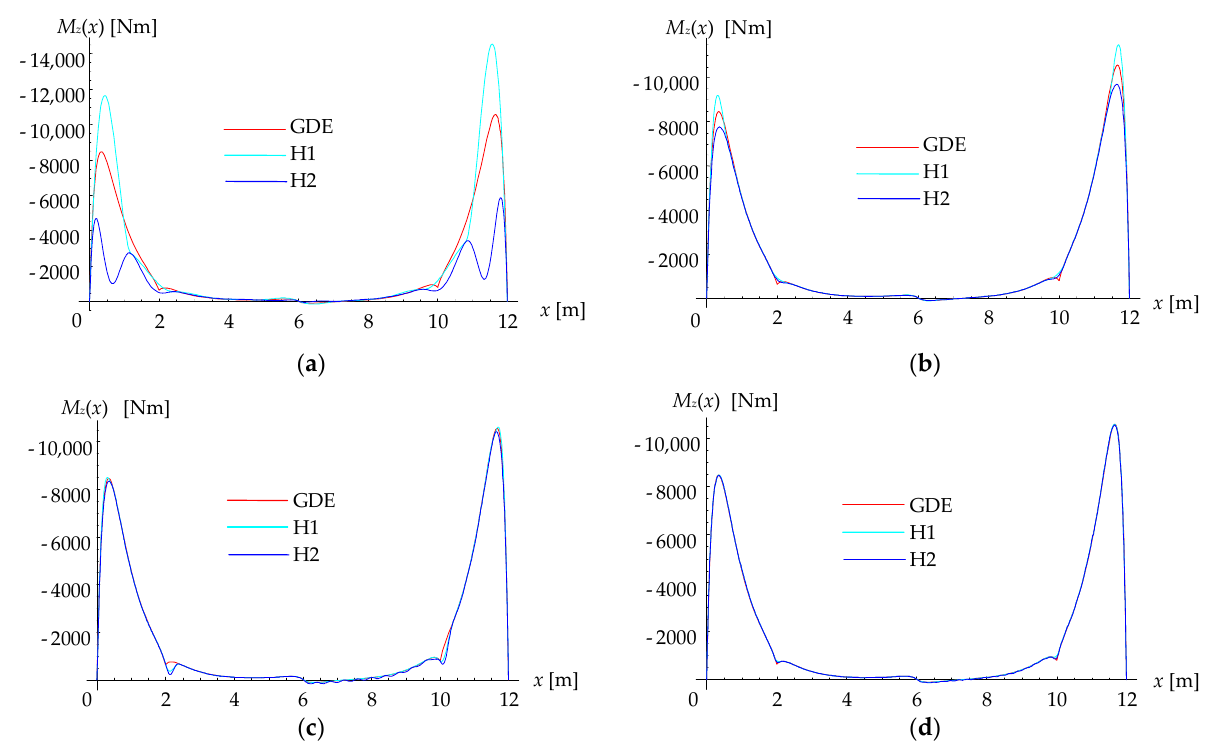
Figure 7. Comparison of bending moments for various FE meshes: ( a ) N e = 10; ( b ) N e = 20; ( c ) N e = 30; ( d ) N e = 50. At last, functions of shear force distributions were calculated. Since these functions are smoother than the bending moment functions, fewer finite elements were required to obtain a very fine agreement of the results. The horizontal axis in Figure 8 represents the distance from the left end of the beam, and the vertical axis represents the results of the shear force. For a small number (i.e., four) of finite elements, as shown in Figure 8a, the H2 interpolation functions (dark blue) produced evidently better matching against GDEs solutions (red) as the H1 (light blue) interpolation functions. However, since the model number of FEs is actually governed by the bending moment functions, the differences between both interpolations became almost irrelevant with the increasing number of FEs as the H1 interpolation functions already produced good matching, as shown in Figure 8b.